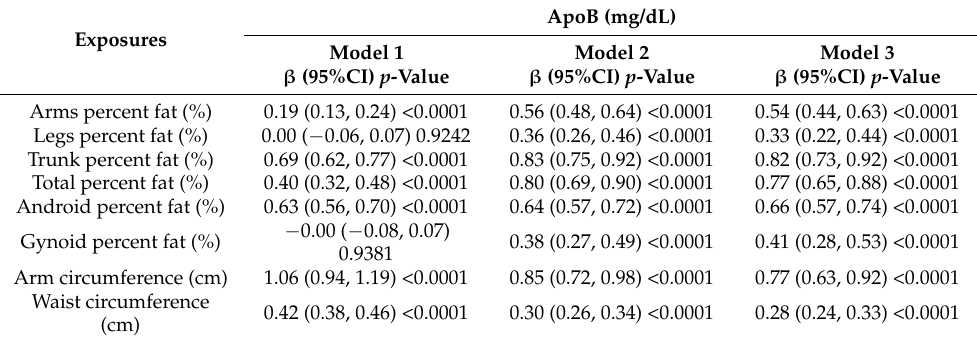
Table 2. Correlation between ApoB and specific fat depot features. Model 1, no covariate was adjusted; Model 2, age, gender, and race were adjusted; Model 3, age, gender, race, hypertension, diabetes, hyperlipidemia, coronary heart disease, smoking status and vigorous work activity were